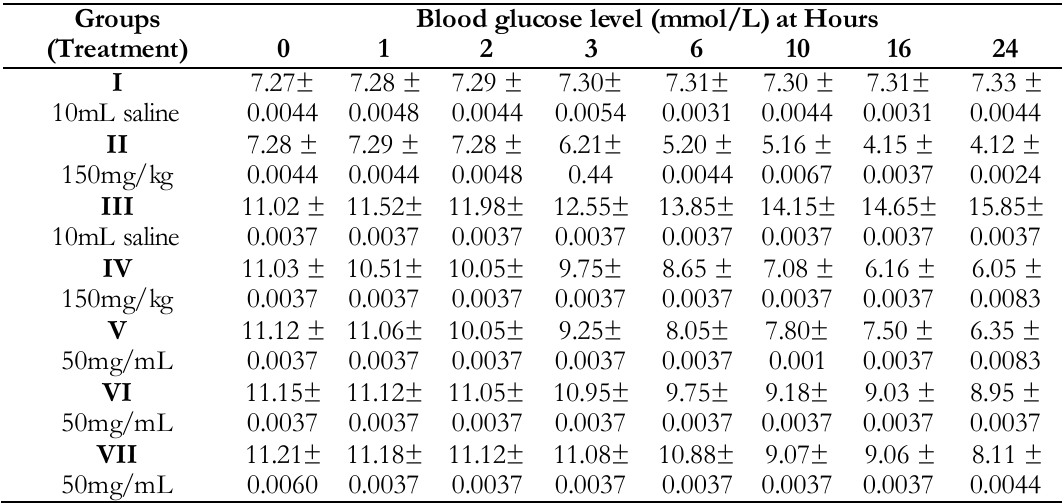
Table III. Effect of various fractions of Hydrolea zeylanica on bood glucose level in diabetic rats on one day